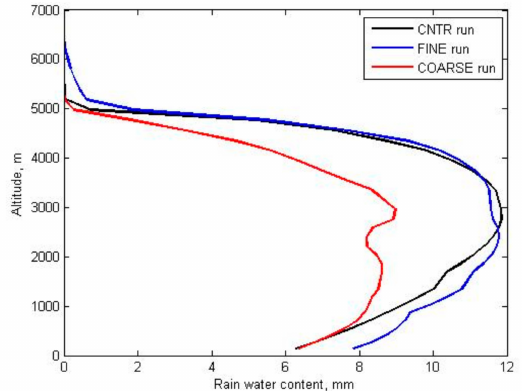
Figure 6. Vertical profiles of rain water in the atmosphere for different